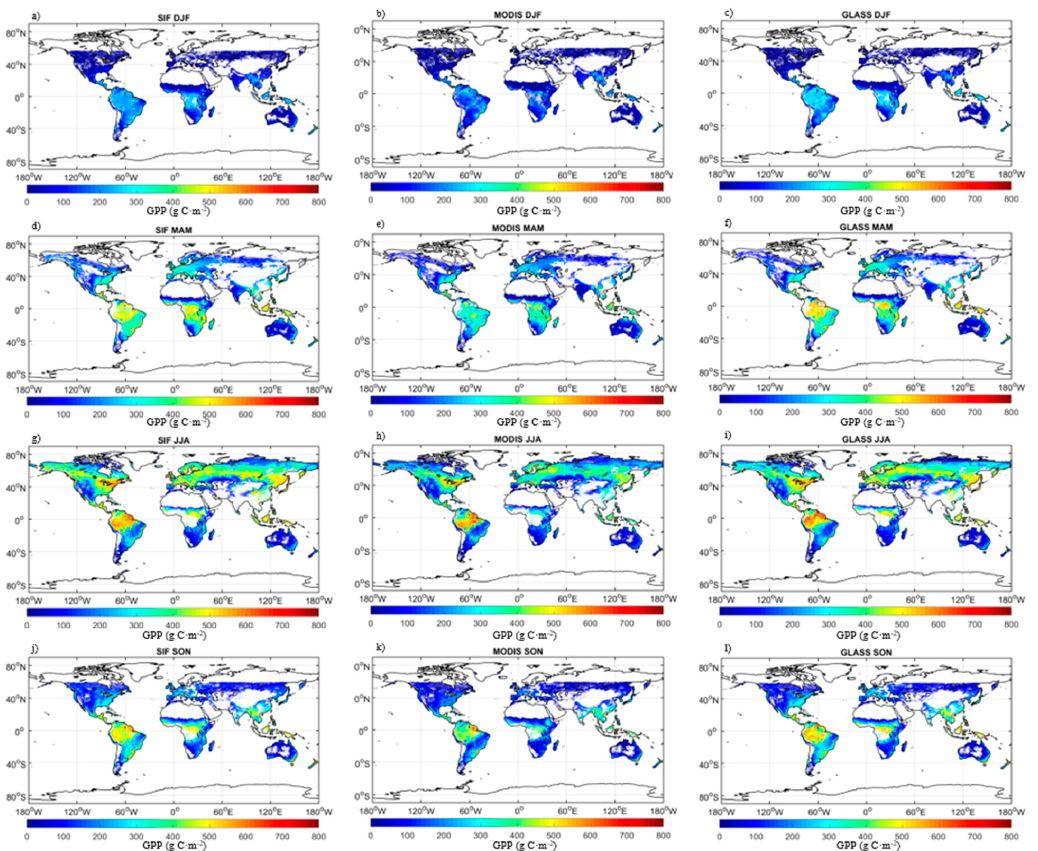
Figure 3. Spatial patterns of global GPP in different seasons of 2014: ( a ) GPP SIF in December, January, and February (DJF);